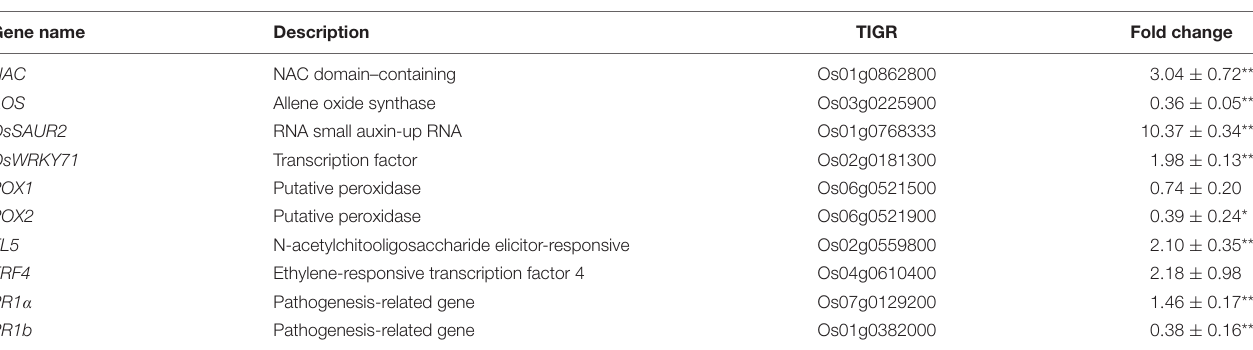
TABLE 3 | The relative expression of selected genes representative for plant defense